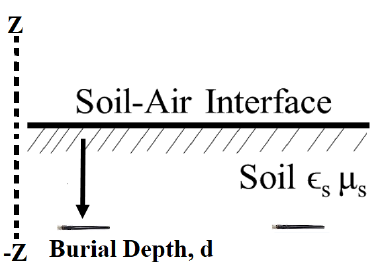
Figure 3. The burial depth and the z